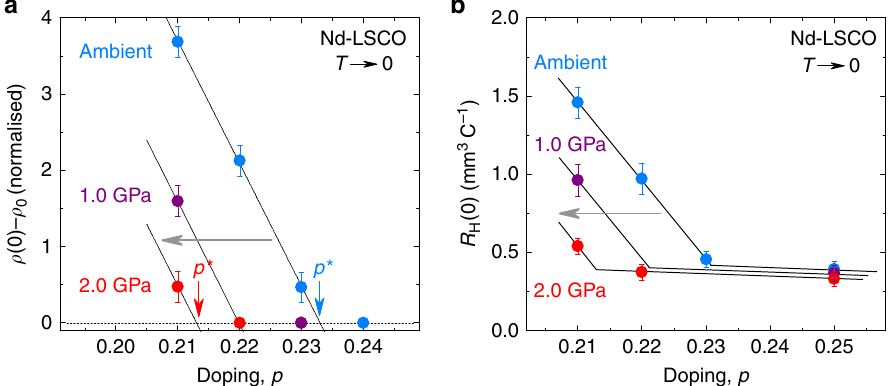
0.20 0.21 0.22 0.23 Fig. 4 Effect of pressure on p *. a Magnitude of the upturn in ρ ( T ) at T → 0 and for H = 33 T as a function of doping, for ambient pressure (blue), P = 1.0 (purple) and 2.0 GPa (red), obtained from ambient pressure data (Fig. 3a) and from pressure data at p = 0.21 (Fig. 3b), p = 0.22 (Fig. 2c) and p = 0.23 (Supplementary Fig. 7). The pseudogap critical point p * is where the upturn goes to zero (arrow). b R H (0) vs doping for ambient pressure (blue), P = 1.0 (purple) and 2.0 GPa (red), obtained from ambient pressure data at p = 0.21, 0.22 and 0.23 (Fig. 3c) for H = 33 T, and p = 0.25 (Supplementary Fig. 4) for H = 16 T, and from pressure data at p = 0.21 (Fig. 3d) and p = 0.22 (Fig. 2d) for H = 33 T, and p = 0.25 (Supplementary Fig. 4) at H = 16 T. All lines are a guide to the eye. The effect of pressure is to shift p * down in doping (grey arrows), by roughly dp * = − 0.02 for 2.0 GPa. All the error bars re fl ect the uncertainty on the extrapolation to T =